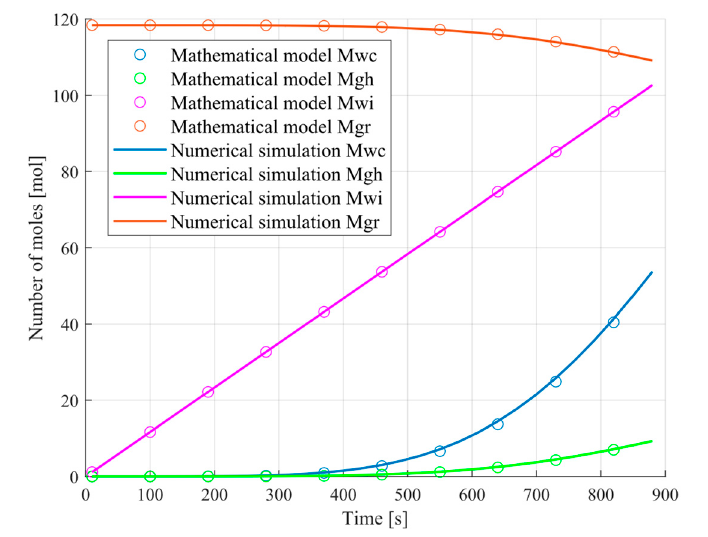
Figure 4. Comparison of hydrate prediction mathematical model and numerical simulation. Table 3. Comparison of hydrate prediction mathematical model and numerical simulation using percentage change. Time